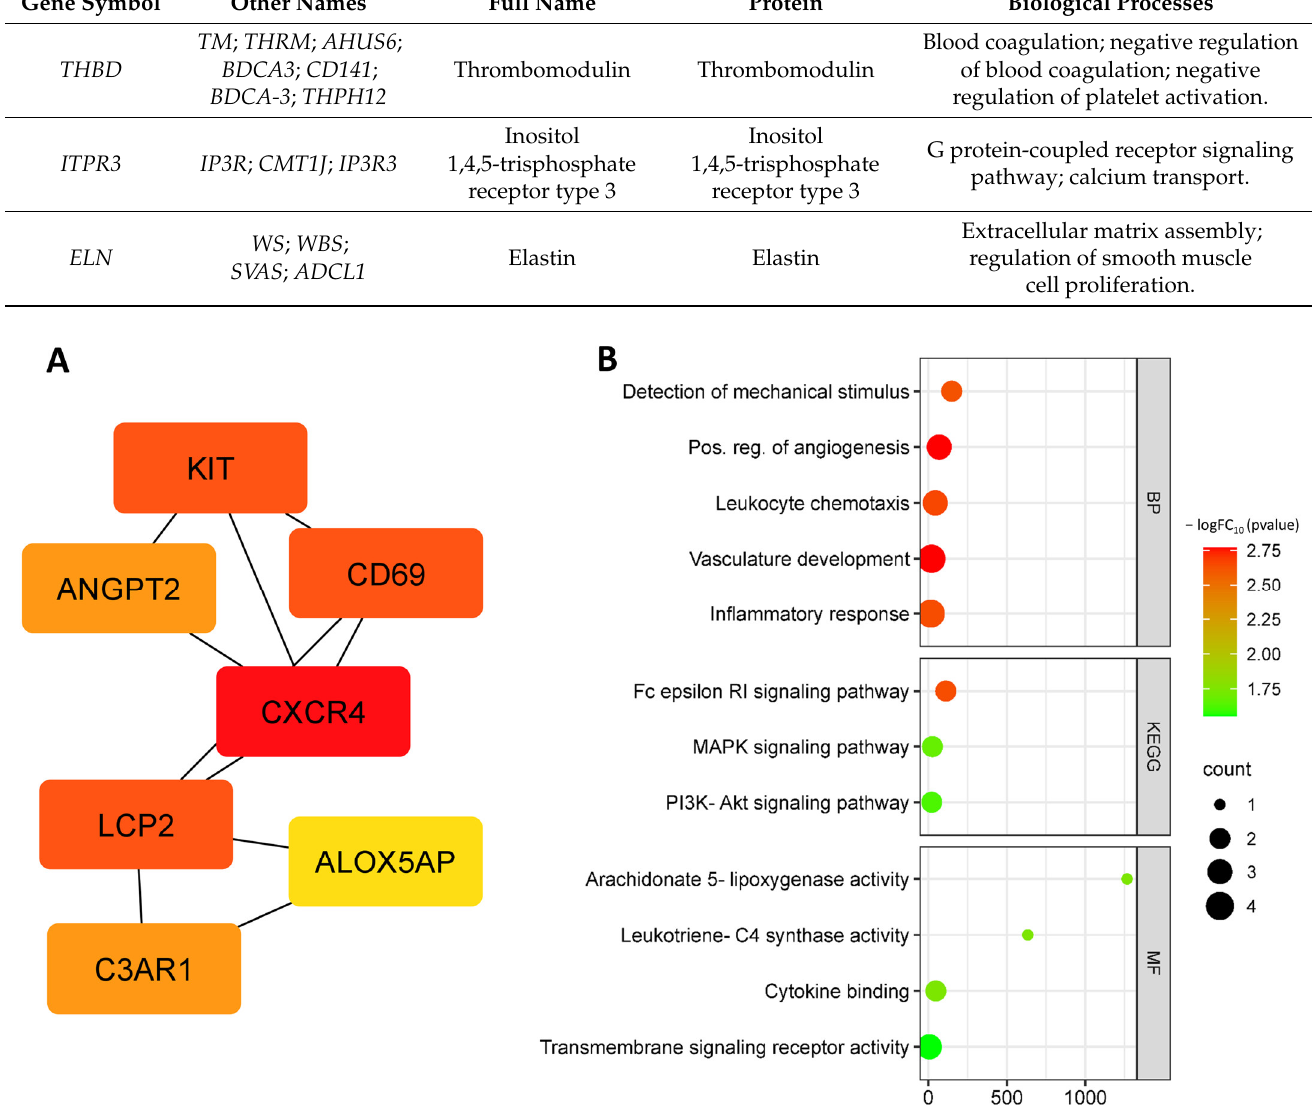
Figure 4. Up-regulated hub DEGs at OS ( A ) and functional enrichment by biological processes of up-regulated hub DEGs at OS ( B ). Table 2. Functional roles and general information of the up-regulated hub